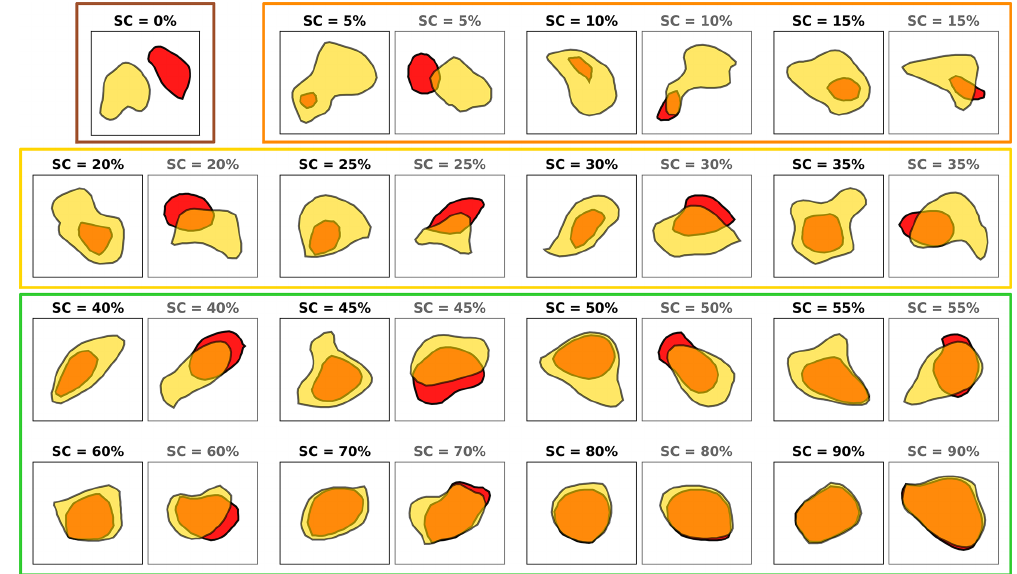
Figure 3. Illustration of the similarity coefficients (SCs) from 0% to 100%. An SC of 0% is when the eddies of one atlas have no match in the other atlas (brown rectangle), SCs strictly below 20% are associated with quite different eddies (orange rectangle), SCs between 20% and 40% are considered as intermediate (yellow rectangle), and SCs over 40% are associated with very similar eddies (green rectangle). Except for unmatched eddies (SC = 0%), on the left the case of one eddy included in the other is presented for each SC, and on the right the case of shifted